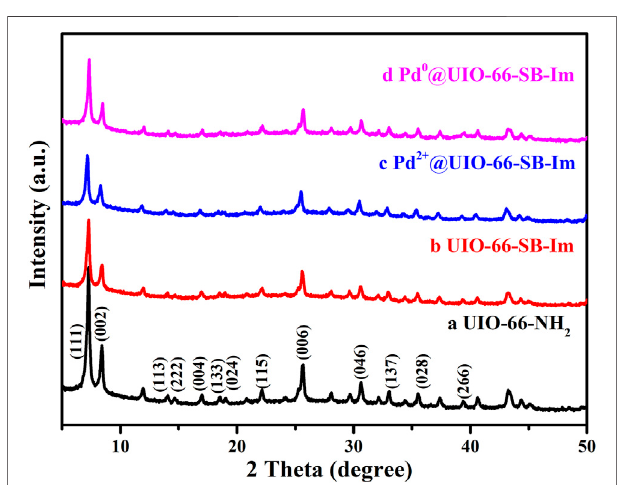
FIGURE 1 | Power X-ray diffraction (PXRD) diffraction patters of UIO- 66 – NH 2 , UIO-66 – SB – Im, Pd 2+ @UIO-66 – SB – Im, and Pd 0 @UIO-66 – SB –